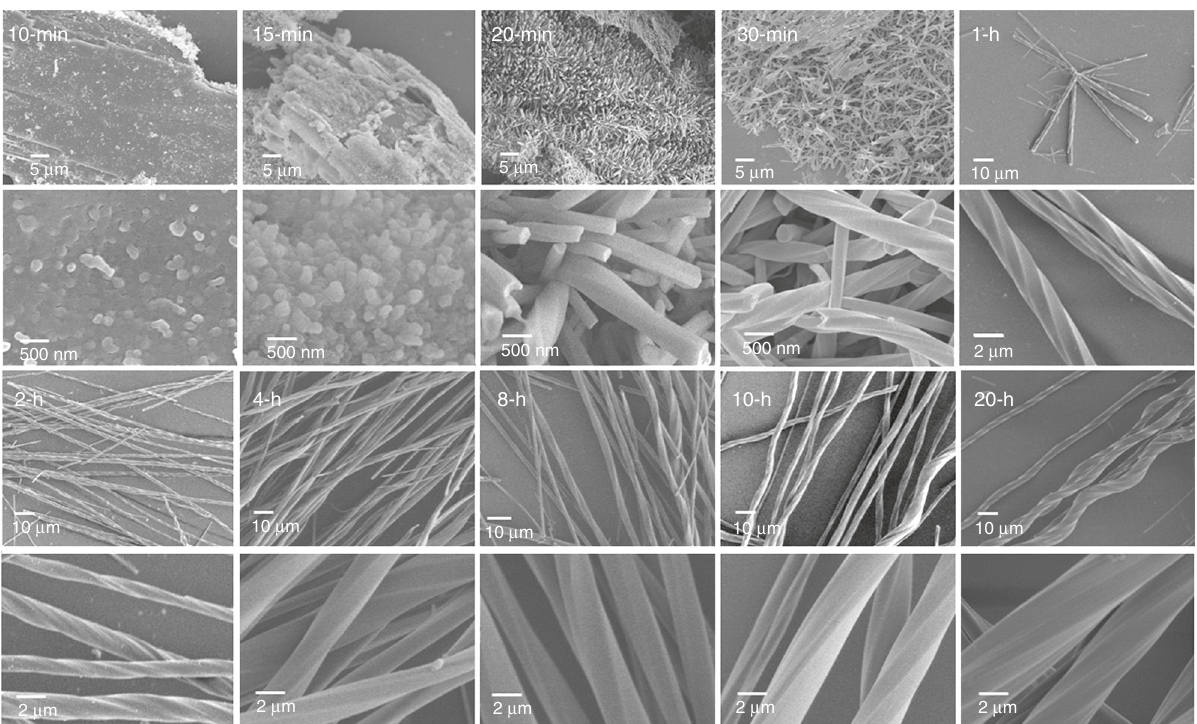
Fig. 6 SEM images of the intermediate self-assembly states. SEM images of the solid products after hydrothermal reactions of Tb(NO 3 ) 3 and R -pempH 2 (pH ~ 3.1) at 120 °C for different period of